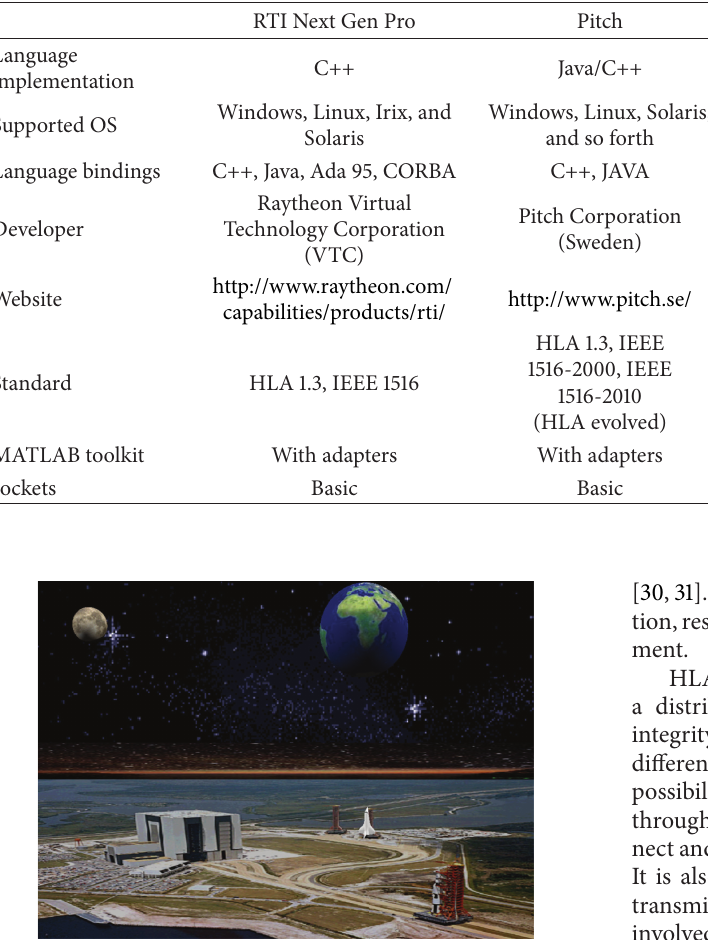
Table 1: M¨AK Real-time RT, Pitch portable RTI (pRTI), and RTI Next Generation RTIs.